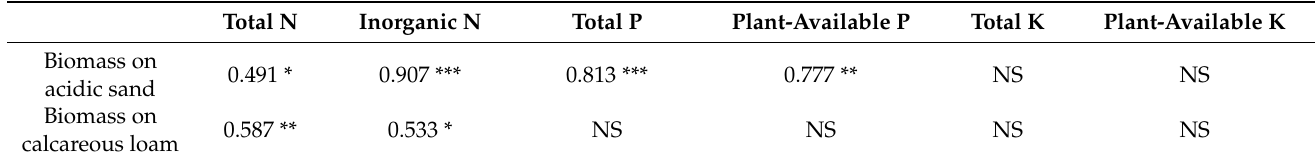
Table 4. Correlation coefficients between soil nutrient contents and the aboveground biomass of perennial ryegrass on the investigated soils.